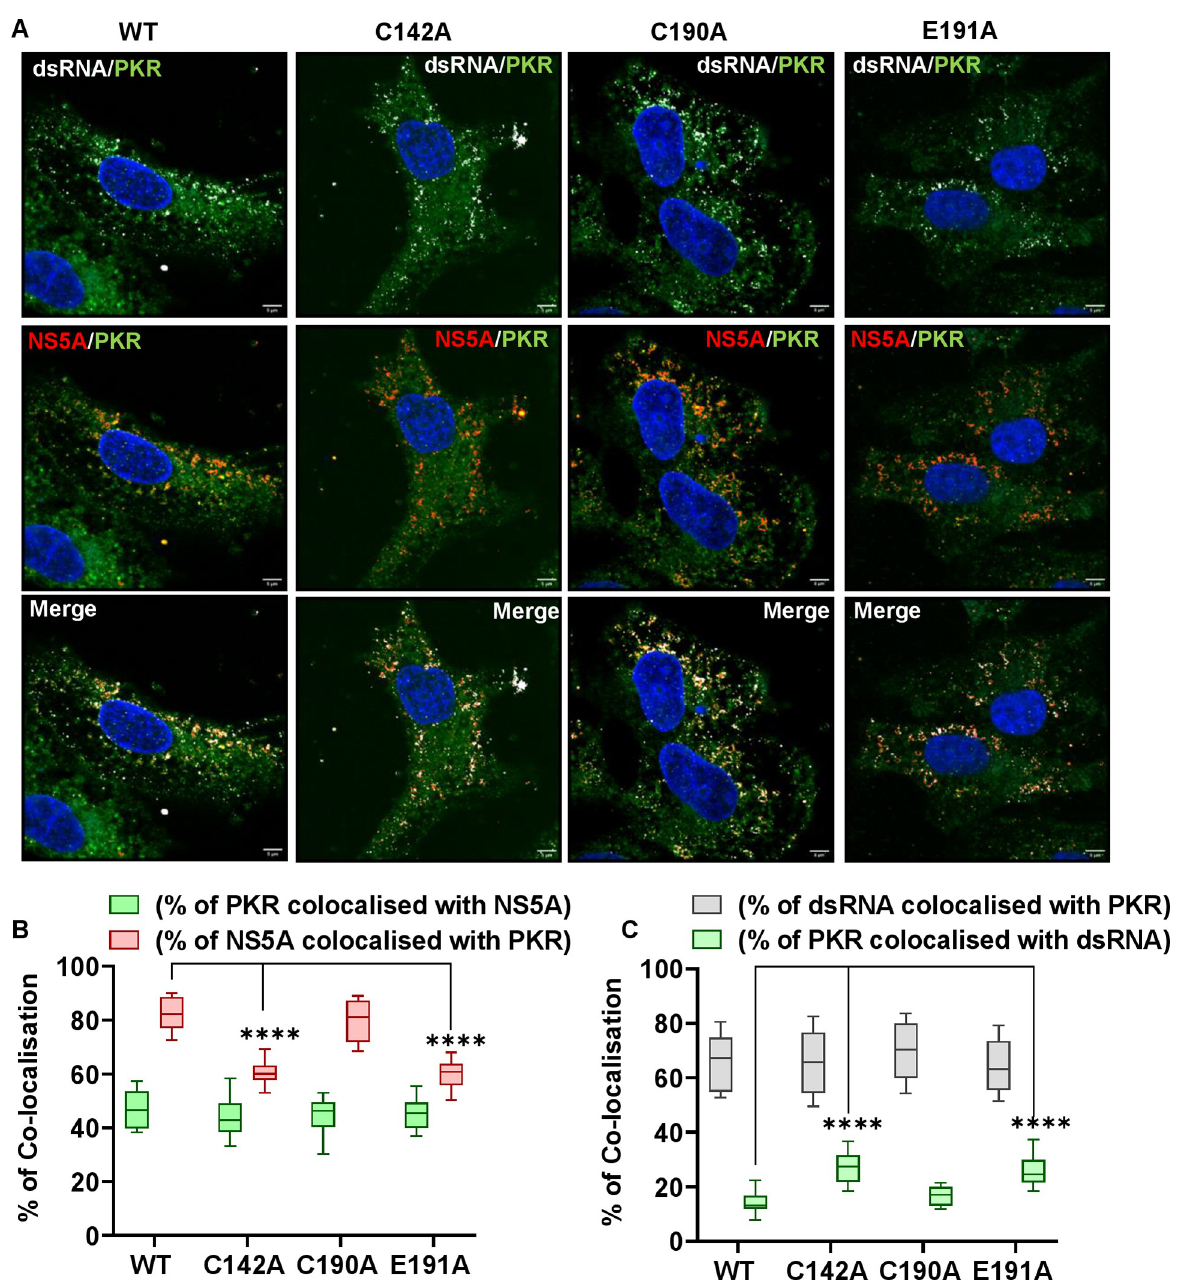
Fig 12. Co-localisation of NS5A, dsRNA and PKR. (A) Huh7.5 cells were electroporated with mJFH-1 WT and DI mutant C142A, C190A and E191A RNAs and seeded on to coverslips. At 72 hpe cells were stained with sheep anti-NS5A (red), mouse anti-dsRNA J2 (white), rabbit anti-PKR (green) and DAPI. Co-localisation was observed using Airyscan microscopy. Representative images are shown. Scale bars are 5 μ m. (B) Quantification of the percentage of PKR colocalized with NS5A (green), and NS5A colocalized with PKR (red). (C) Quantification of the percentage of dsRNA colocalized with PKR (grey), and PKR colocalized with dsRNA (green). Co-localisation was analyzed in 10 cells using Fiji. Significant differences from WT denoted by ���� (P < 0.0001).